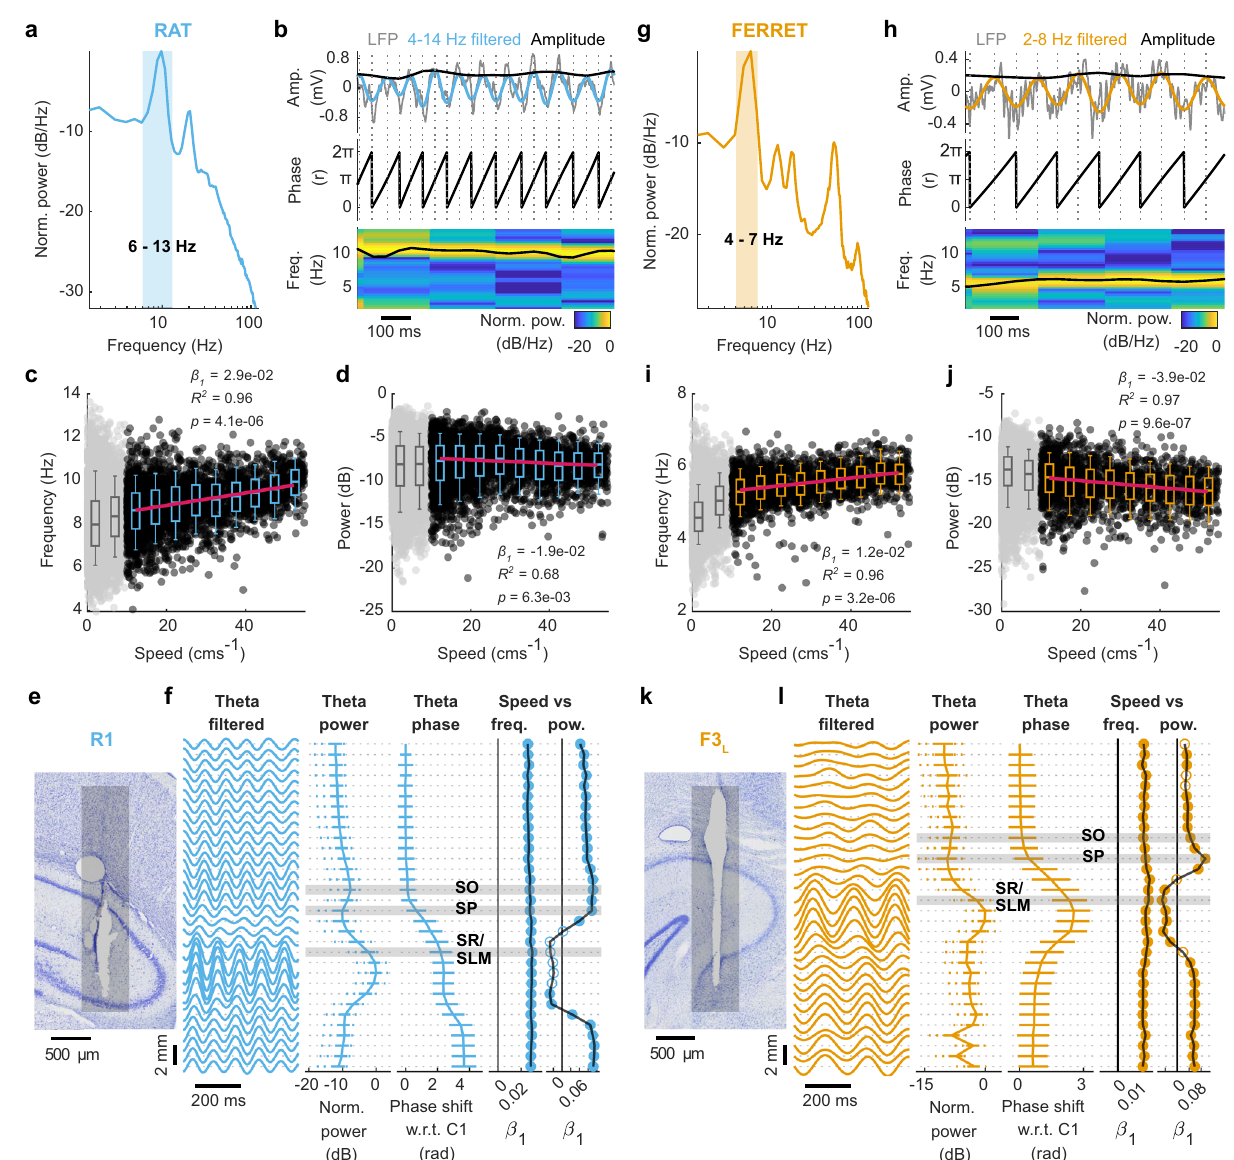
Fig.3|Rat-likethetaoscillationintheferrethippocampusduringlocomotion. Theta characteristics in rat R1. a LFP power spectral density on the highest power channel during locomotion (single session). Blue shading indicates 6 – 13Hz range. b Peak-trough method for estimating theta properties: Example data from the channel/sessionshownin a withLFP(1Hzhigh-pass fi ltered;grey)andtheta fi ltered activity (4 – 14Hz; blue). Dashed lines indicate extrema used to estimate instanta- neous amplitude, phase and frequency. Frequency is shown overlaid on spectro- gram of the above LFP signal (normalised to maximum). Relationship between locomotor speed and frequency ( c ) or power ( d ) for data shown in a . Data-points represent median values in 250ms epochs during locomotion (black, n =6857) or when the animal was not moving (<10 cms − 1 ; grey, n =7565, excluded from regressions). Box plot centres show median, box bounds show interquartile range andwhiskersshow9th – 91stpercentileoffrequency/powerbinnedbyspeed(5cms − 1 bins). Speeds over the 90th percentile were excluded (>55cms − 1 ) due to small sample sizes. Regression line fi tted to median values ( n =9) in each speed bin (pink), text shows linear regression parameters. e Nissl-stained section of hippo- campus showing estimated electrode track (grey bar). f Depth pro fi le of theta